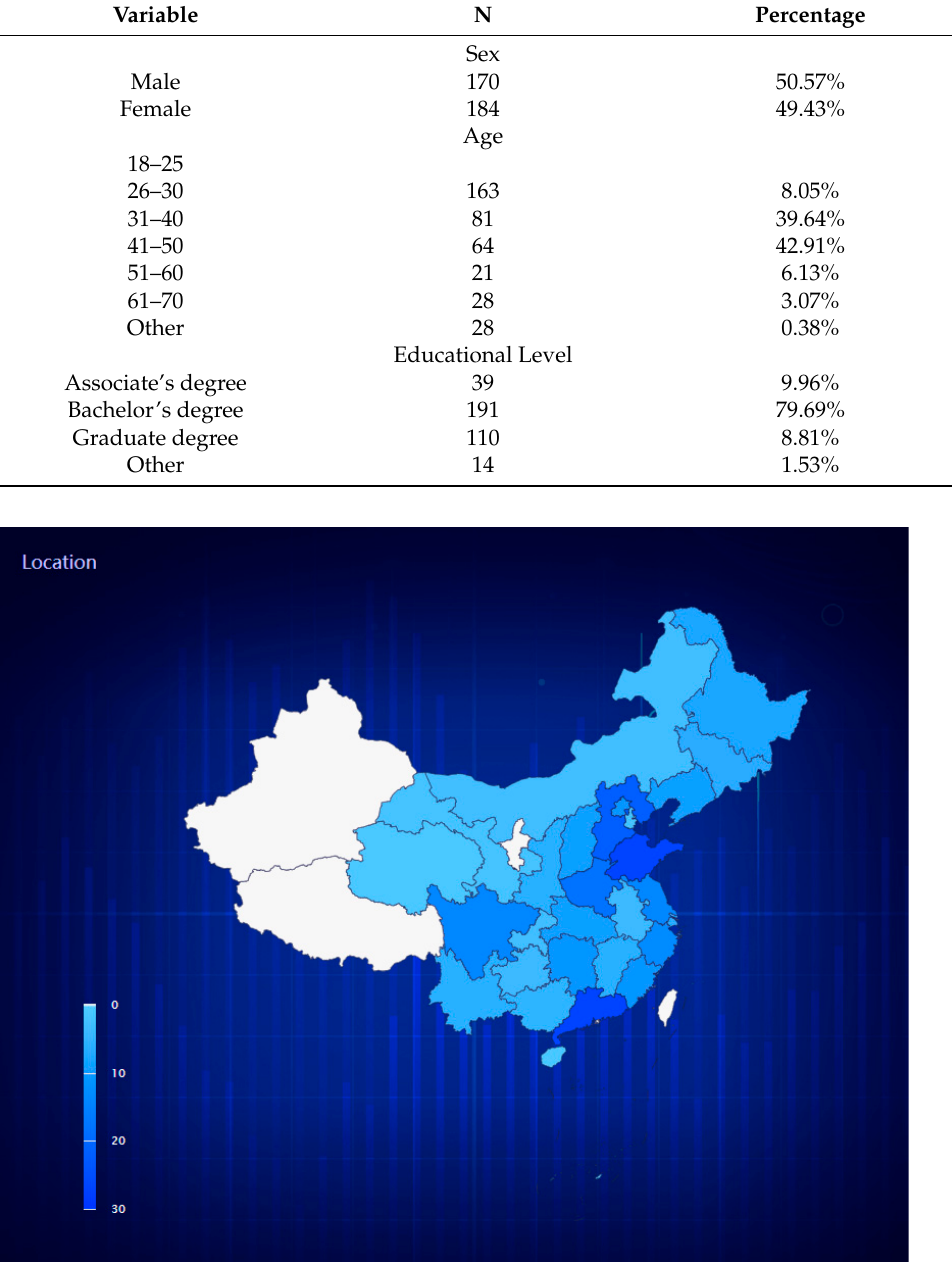
Figure 4. The location sources of the survey. Table 2. Profile of survey respondents (n = 261).